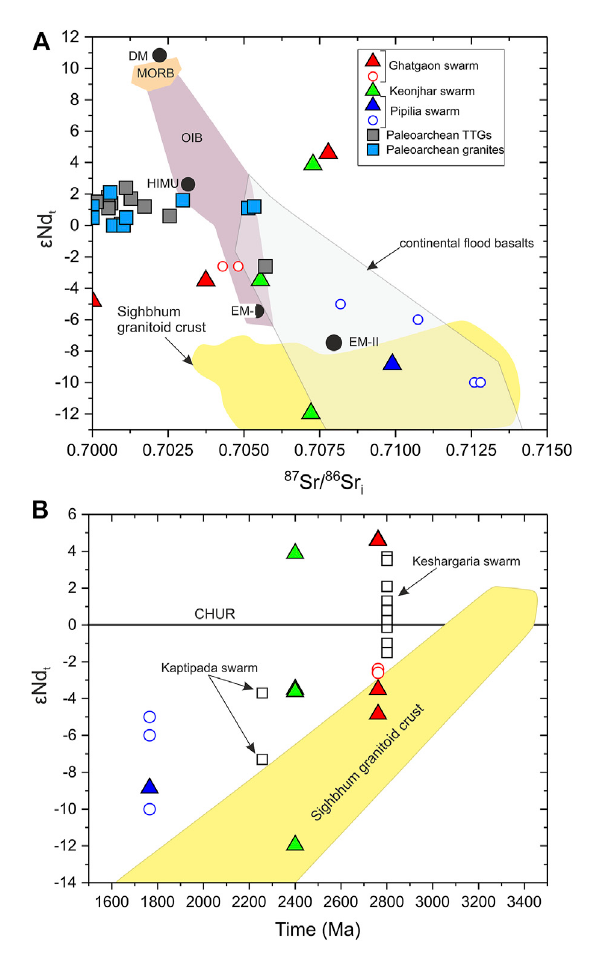
FIGURE 6 (A) Whole-rock 87 Sr/ 86 Sr i versus ε Ndt variations of Ghatgaon, Keonjhar and Pipilia dyke swarms. The Sr-Nd isotope variation of Paleoarchean TTGs and granites of Singhbhum craton is from Upadhyay et al. (2019). The fi elds and average values of the depleted mantle (DM), mid-ocean ridge basalts (MORB), ocean island basalts (OIB), OIB withhigh μ (HIMU),enrichedmantle-1(EM-1),enrichedmantle-2(EM-2) and continental fl ood basalts are from Dorais et al. (2005). Fields of Singhbhum granitoids represent recalculated values corresponding to the ages of dyke swarms. (B) Whole-rock ε Ndt versus time (Ma) plot of dyke swarms of Singhbhum craton. The Nd evolution array of the Singhbhum granitoid crust from Pandey et al. (2021). Data from